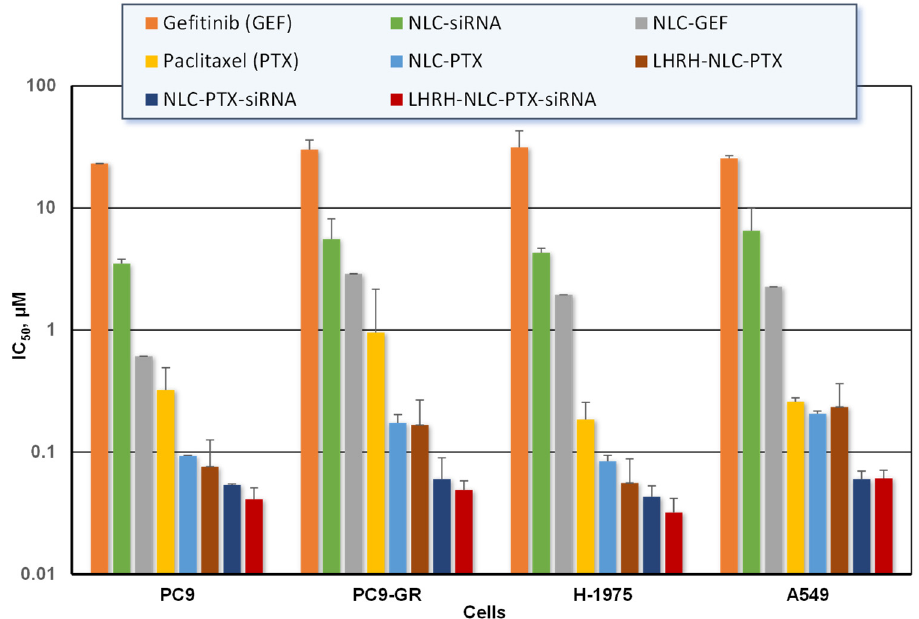
Figure 9. Cytotoxicity of free and NLC-bound drug formulations against various NSCLC cells. Means ± SD are shown.